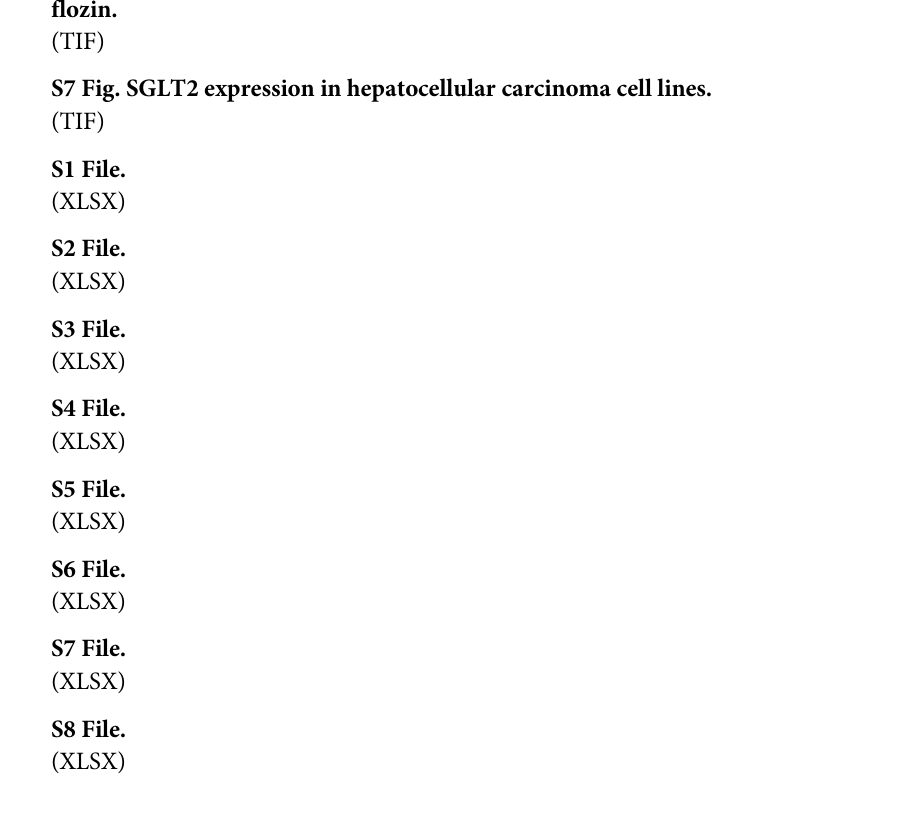
S1 Fig. Ipragliflozin attenuated liver fibrosis using NAFLD fibrosis score. (TIF) S2 Fig. SGLT1 and SGLT2 expression in the small intestine. S3 Fig. p21 mRNA expression by ipragliflozin in small intestine cancer cell line. S4 Fig. p21 expression in the small intestine between Control and Ipragliflozin group. S5 Fig. Microarray data analysis revealed that miR-34a-5p, miR-149-5p, and miR-122-5p expressions were not significantly changed in the serum of STAM mice treated with ipra- gliflozin. S6 Fig. Microarray data analysis revealed that miR-34a-5p, miR-149-5p, and miR-122-5p expressions were not significantly changed in the liver of STAM mice treated with ipragli- flozin. S7 Fig. SGLT2 expression in hepatocellular carcinoma cell